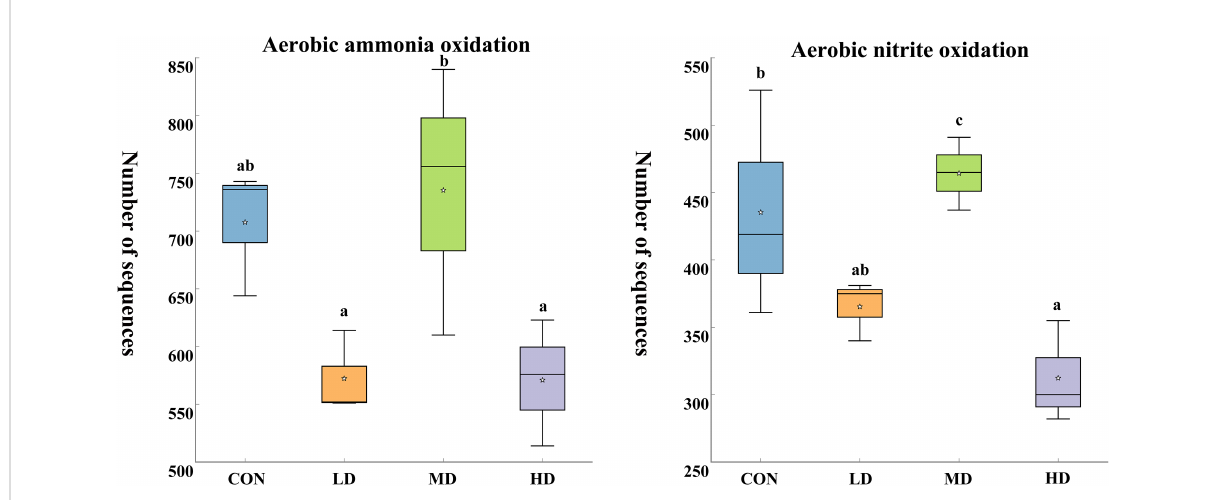
FIGURE 10 Signi fi cantly different functional groups related to nitrogen cycling in sediments of the CON, LD, MD, and HD groups at the end of the experiment. Different lowercase letters represent signi fi cant differences between the CON, LD, MD, and HD groups ( P <